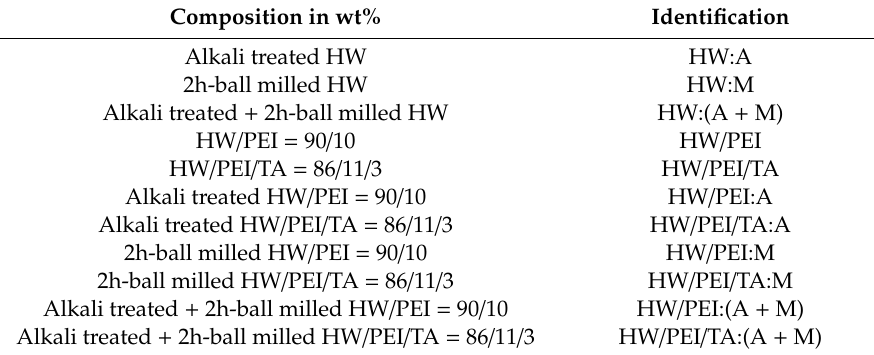
Table 1. Hardwood (HW) without or with binder (PEI or PEI / TA) using di ff erent pre-treatments. Composition in wt%